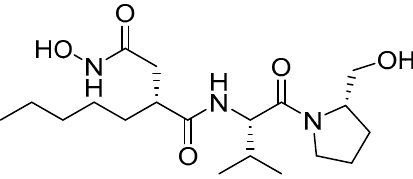
Figure 11. Structure of actinonin, a microbial metabolite targeting chloroplastic peptide deformylase.